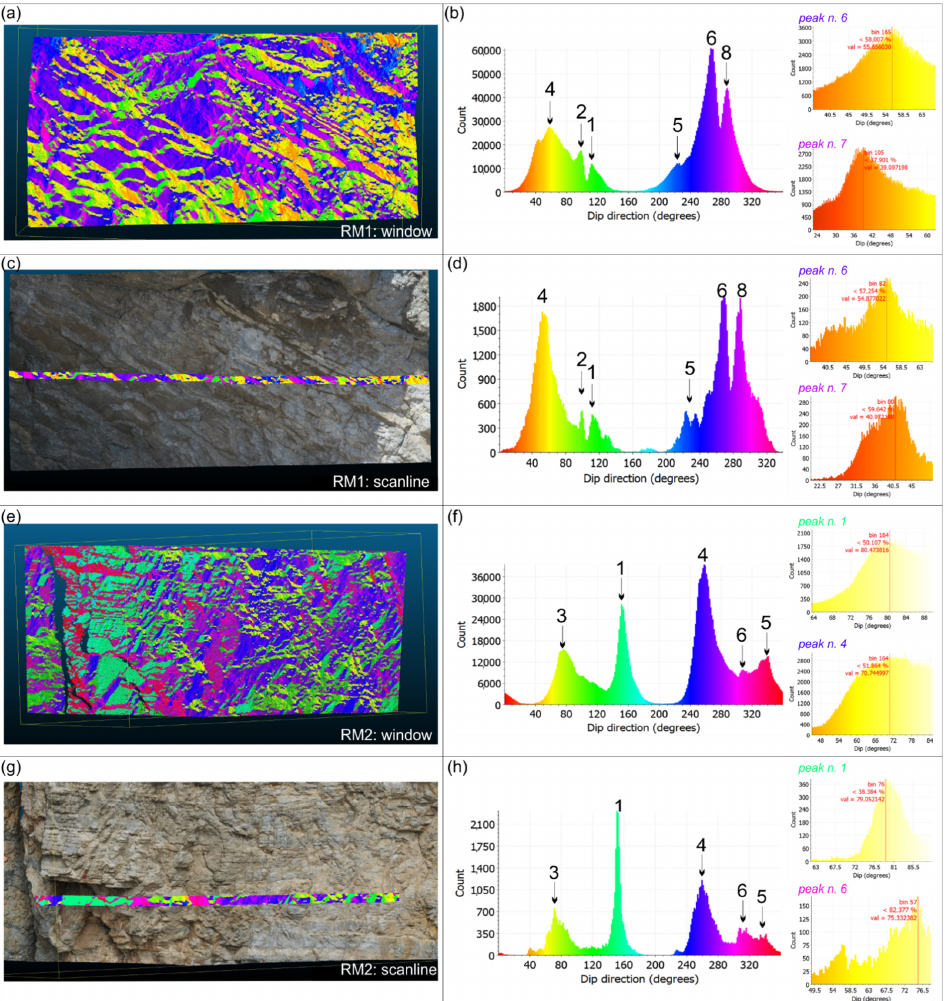
Figure 4. Outcomes of the discontinuity extraction by the scalar field approach. ( a ) Extraction window at RM1; ( b ) frequency histogram of dip direction data with two examples of dip angle frequency distribution for selected peaks of RM1; ( c ) extraction scanline along RM1; ( d ) frequency histogram of dip direction data with two examples of dip angle frequency distribution for selected peaks of RM1; ( e ) extraction window at RM2; ( f ) frequency histogram of dip direction data with two examples of dip angle frequency distribution for selected peaks of RM2; ( g ) extraction scanline along RM1; ( h ) frequency histogram of dip direction data with two examples of dip angle frequency distribution for selected peaks of RM1.